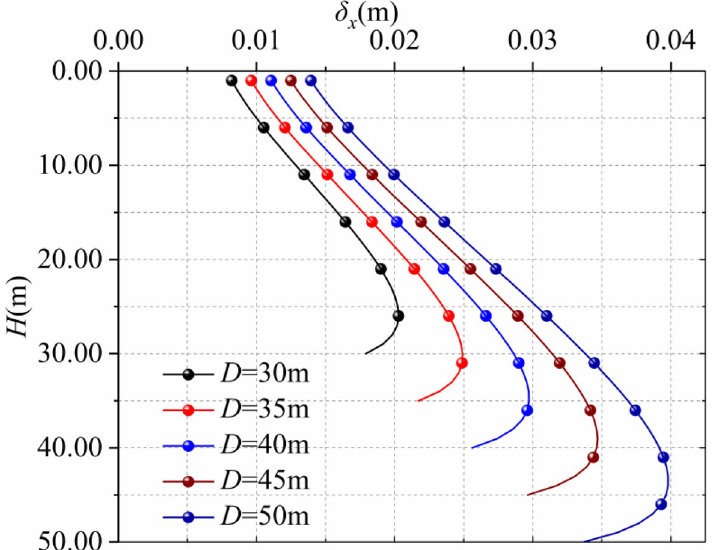
Figure 10. Horizontal displacement of different excavation depths.